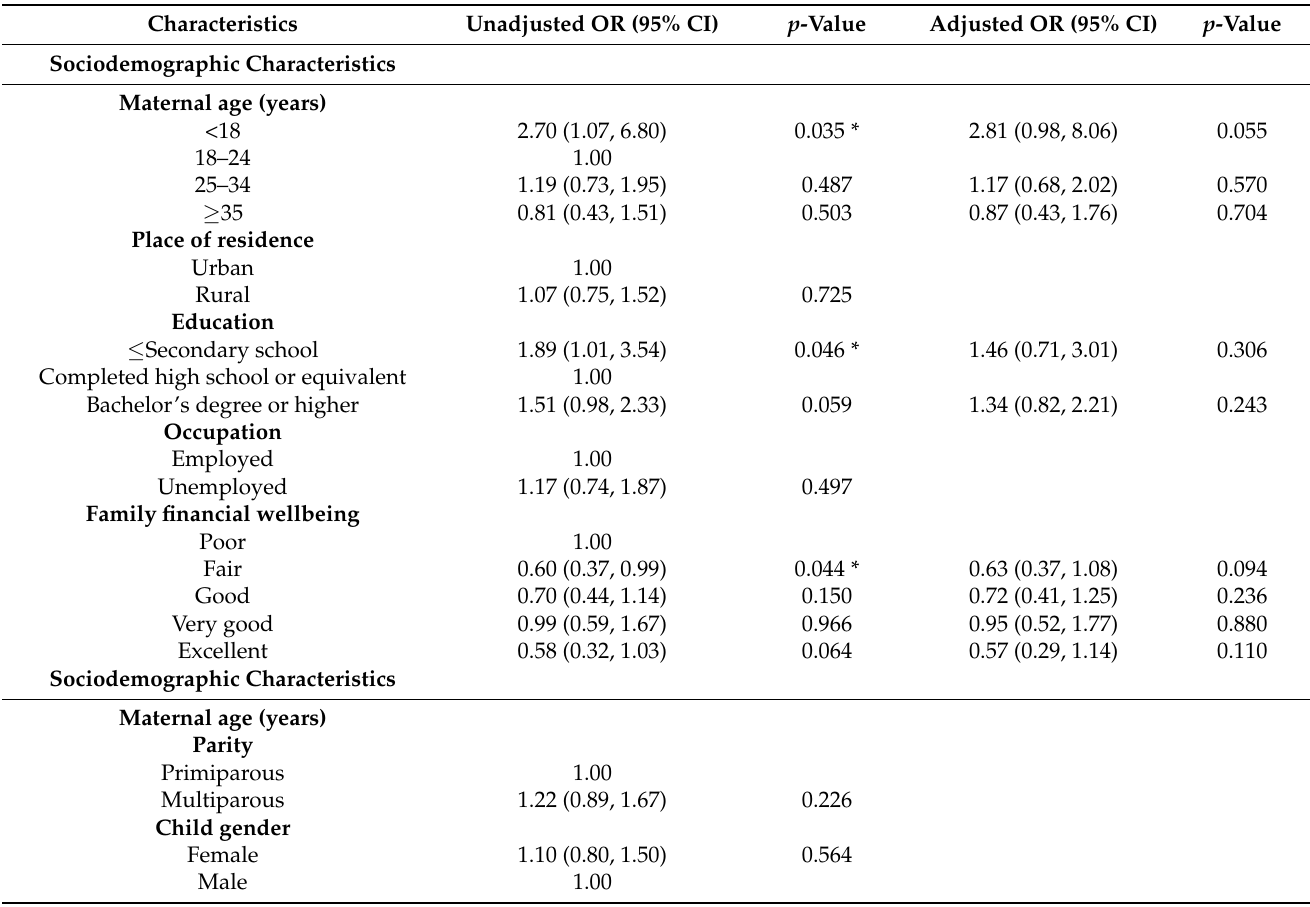
Table 3. Unadjusted and adjusted odds ratios of sociodemographic and pre/perinatal factors associated with exclusive breastfeeding under 6